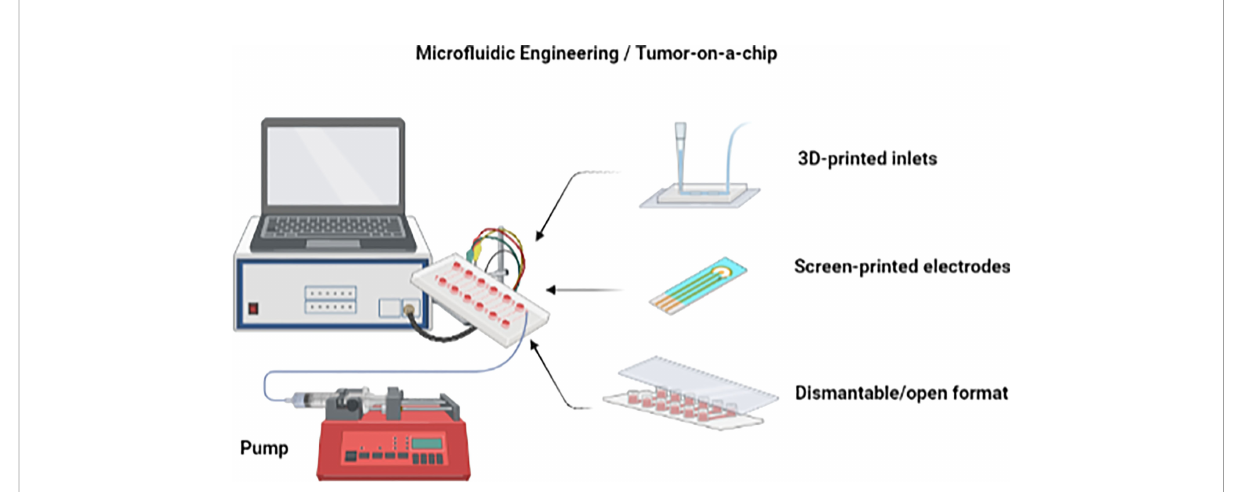
FIGURE 7 Advances in micro fl uidic technology. Micro fl uidic devices as tumor-on-a-chip may incorporate 3D-printed components and a dismantable/ open format. Figure created with